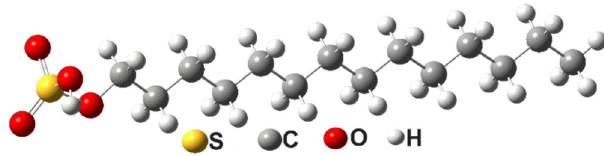
Figure 2. Optimized chemical structure of STS.